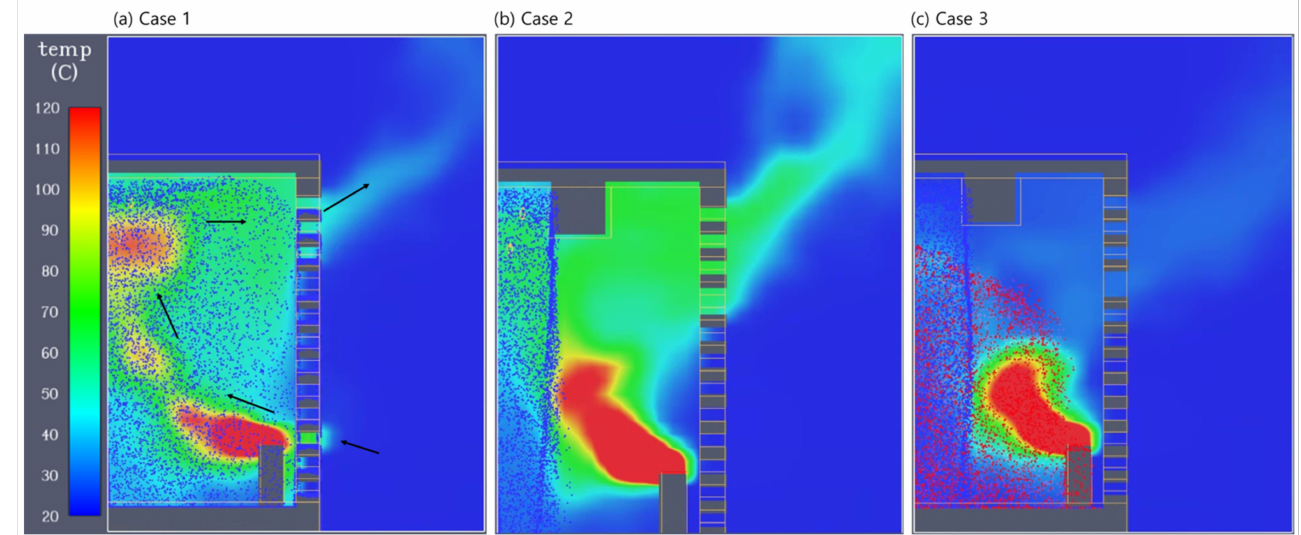
Figure 3. Temperature contour of XZ plan Y = 0, ( a ): Case 1, ( b ): Case 2, ( c ): Case